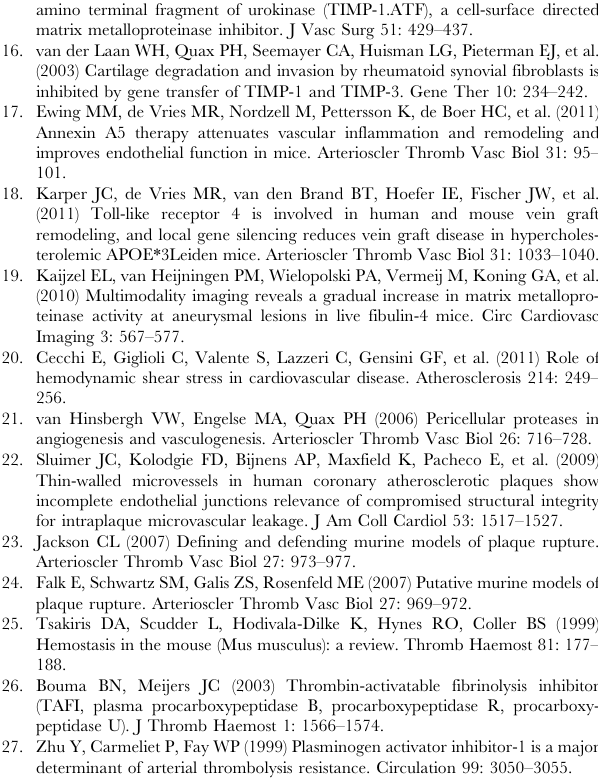
sections of A and B. Information S1 Methods for immunohistochemistry used in this